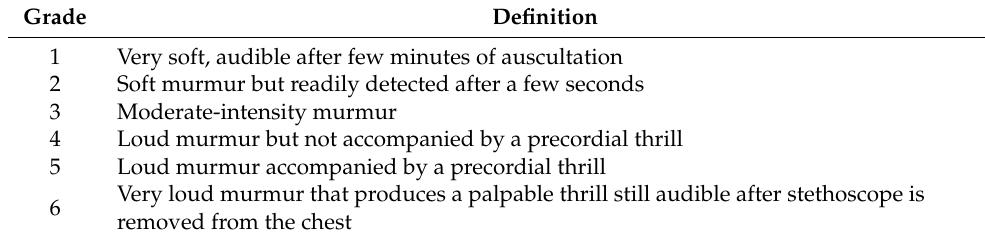
Table 1. Murmur grading scheme.